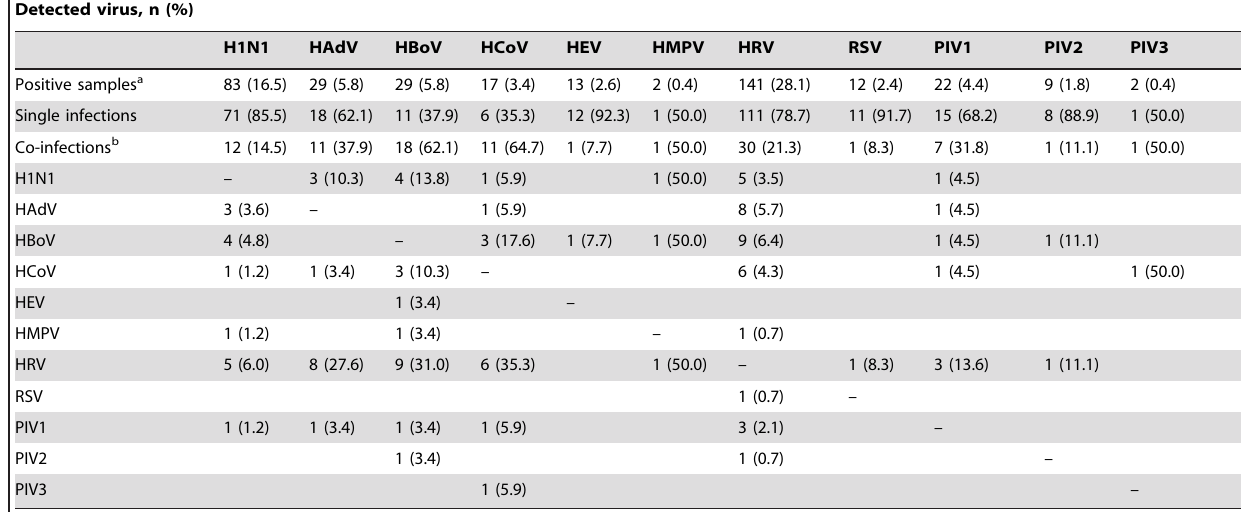
Detected virus, n